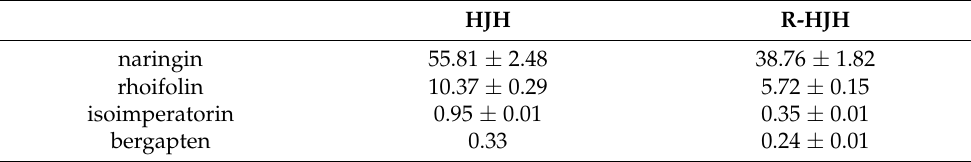
Table 2. The content of flavone and coumarin (mg/g) in the whole fruit of R-HJH and